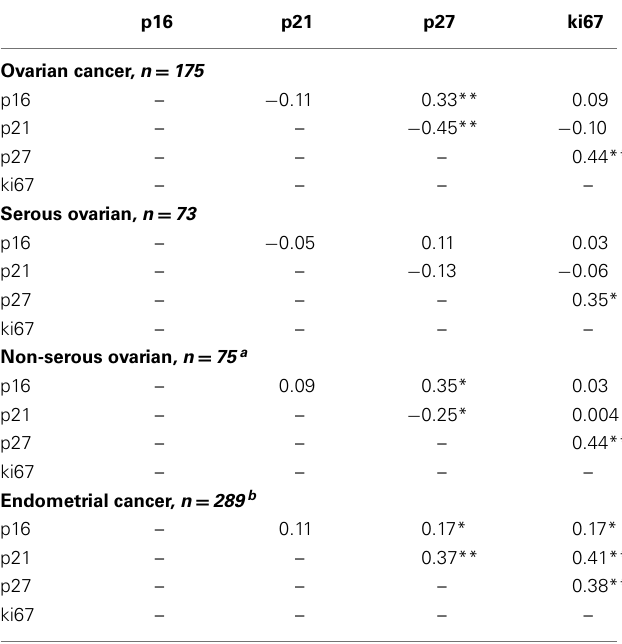
Table 2 | Spearman correlation coefficients between cell-cycle markers by cancer site .